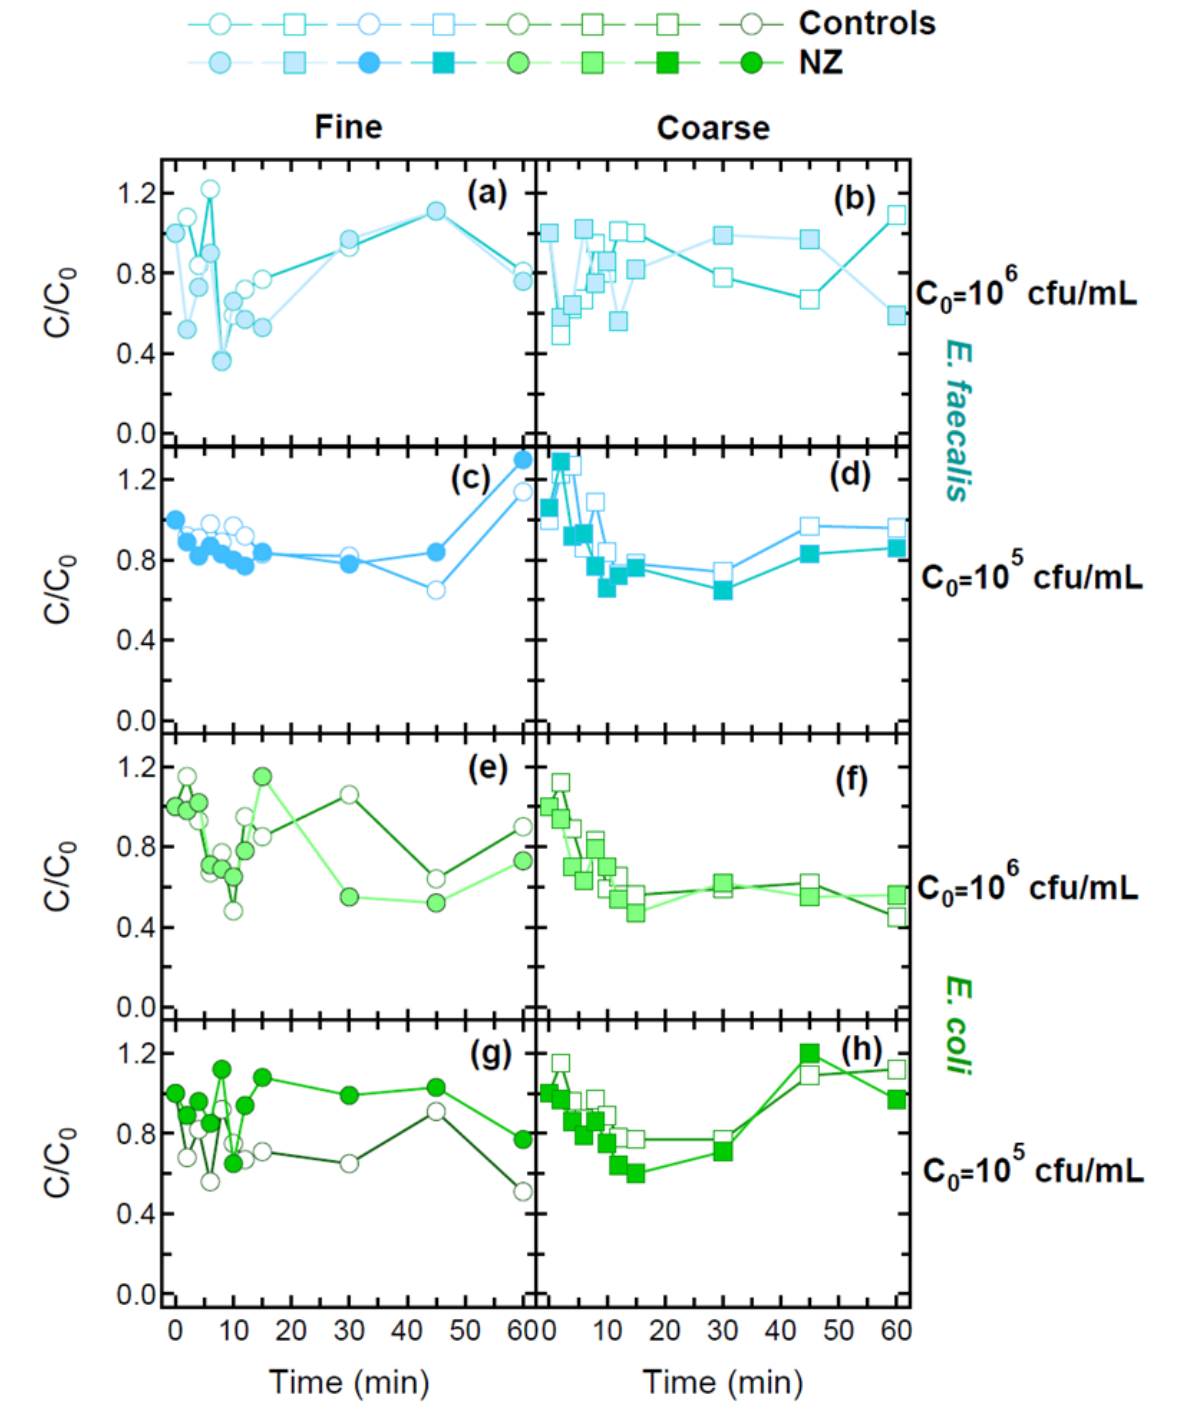
Figure 3. Experimental inactivation data of E. faecalis ( a – d ) and E. coli ( e – h ) removal by fine (0–1 mm) NZ ( a – g ) and coarse (1–3 mm) NZ ( b – h ) in the absence (empty symbols) and the presence (filled symbols) of natural zeolites. Bacterial initial concentrations: 10 6 and 10 5 cfu/mL.